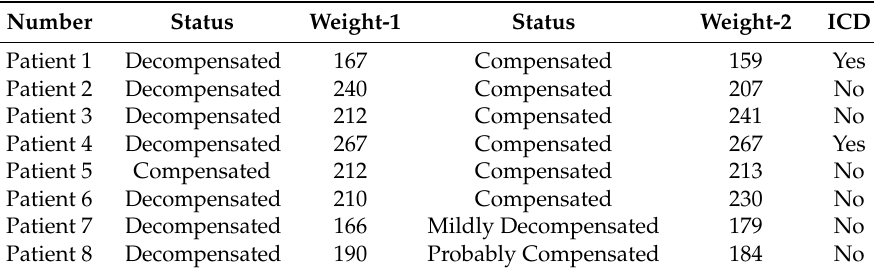
Table 1. Weight measurement at two different